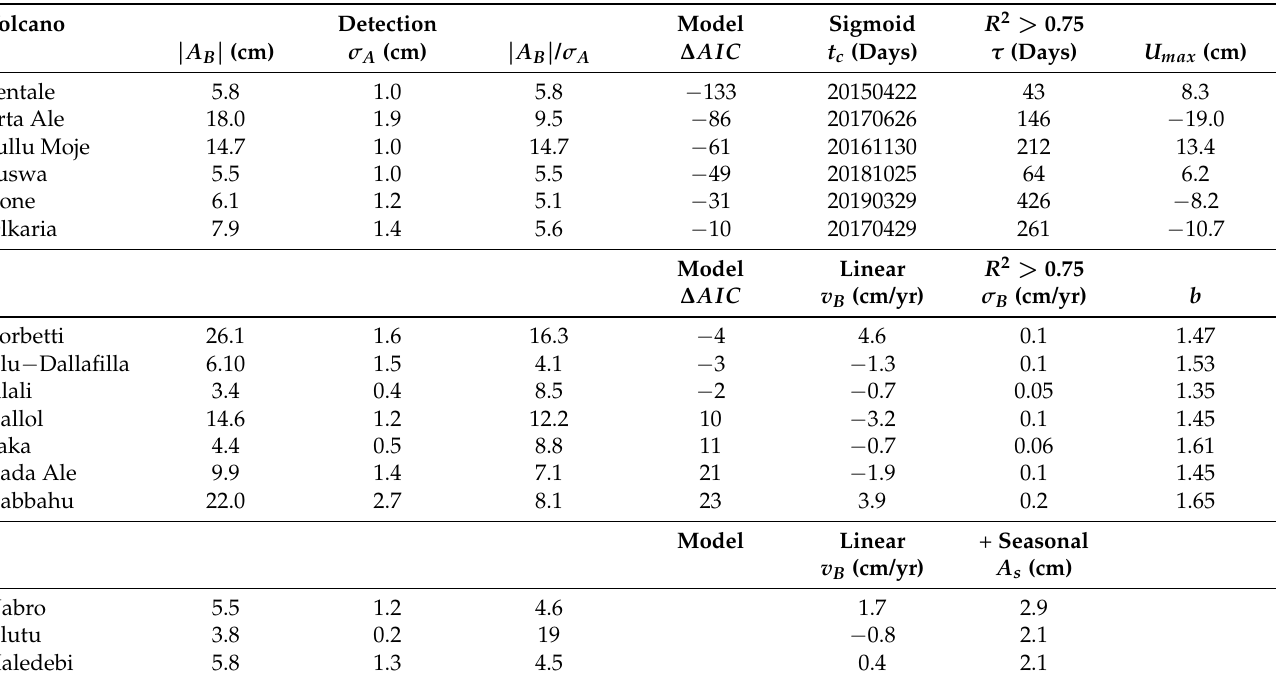
Table 2. Values of the signal-to-noise ratio and the best-fit model for InSAR time series of all volcanoes where | A B | > 3 σ A